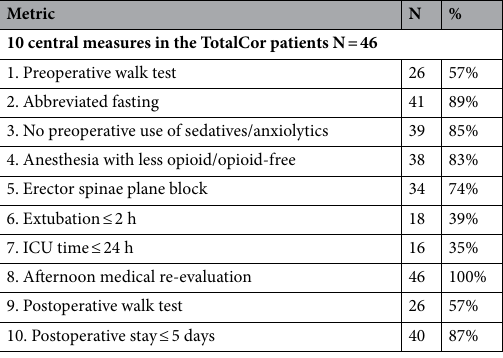
Table 1. TotalCor protocol adherence.